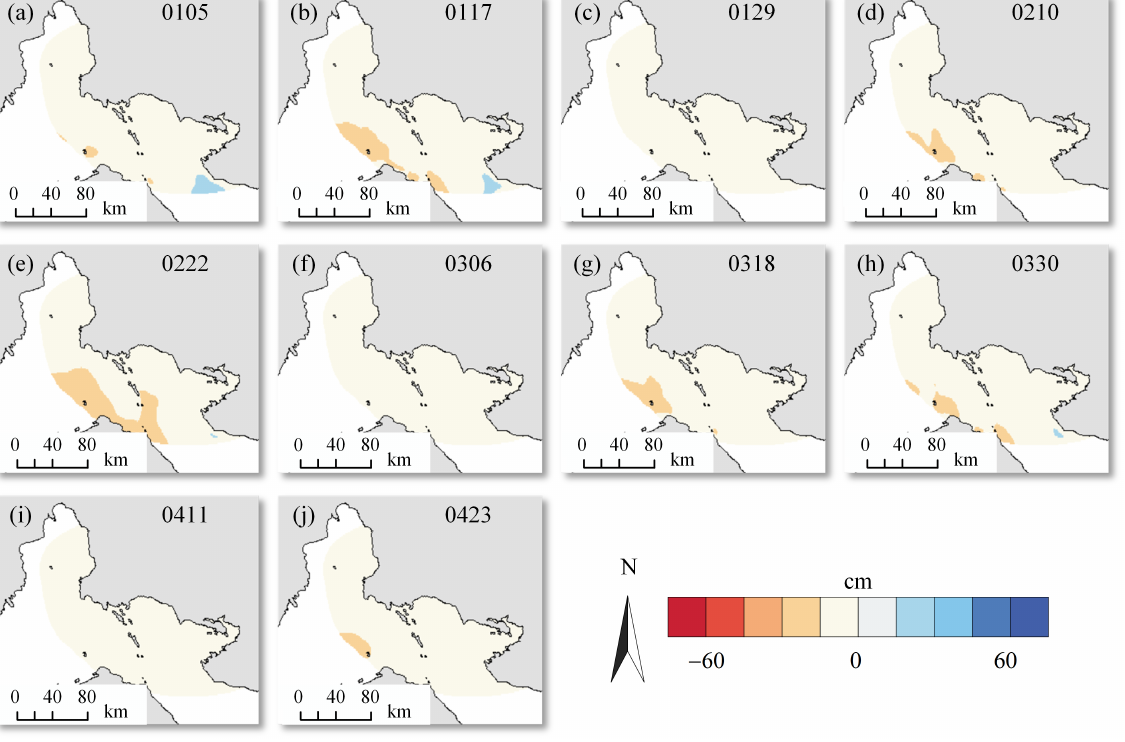
Figure A6. Time-series LOS deformation retrieved from the 2021 ascending images: the top-right number of subfigures ( a – j ) represents the corresponding SAR images acquisition